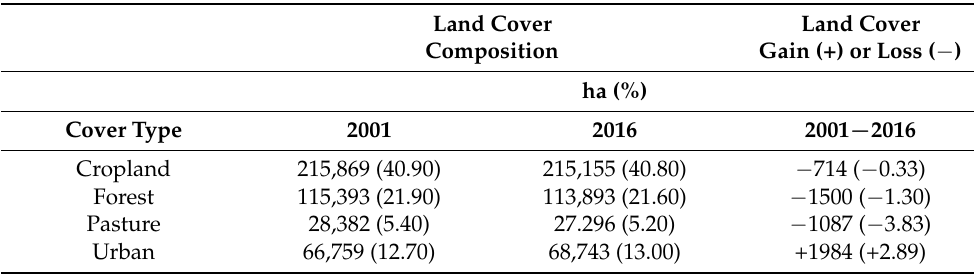
Table 1. Land cover composition in ha (%) of the Kalamazoo River Watershed, and net gain (+) and loss ( − ) for each cover type during the period 2001–2016.